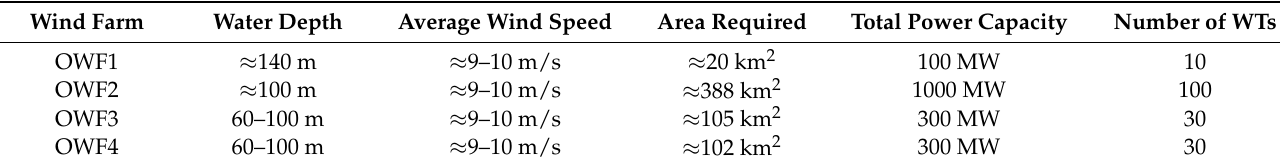
Table 5. Specs of the offshore wind farms.